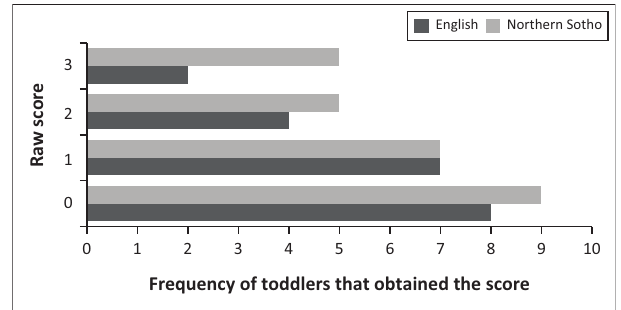
FIGURE 3 : Risk profile according to the raw score for each version of the Modified Checklist for Autism in Toddlers, Revised with